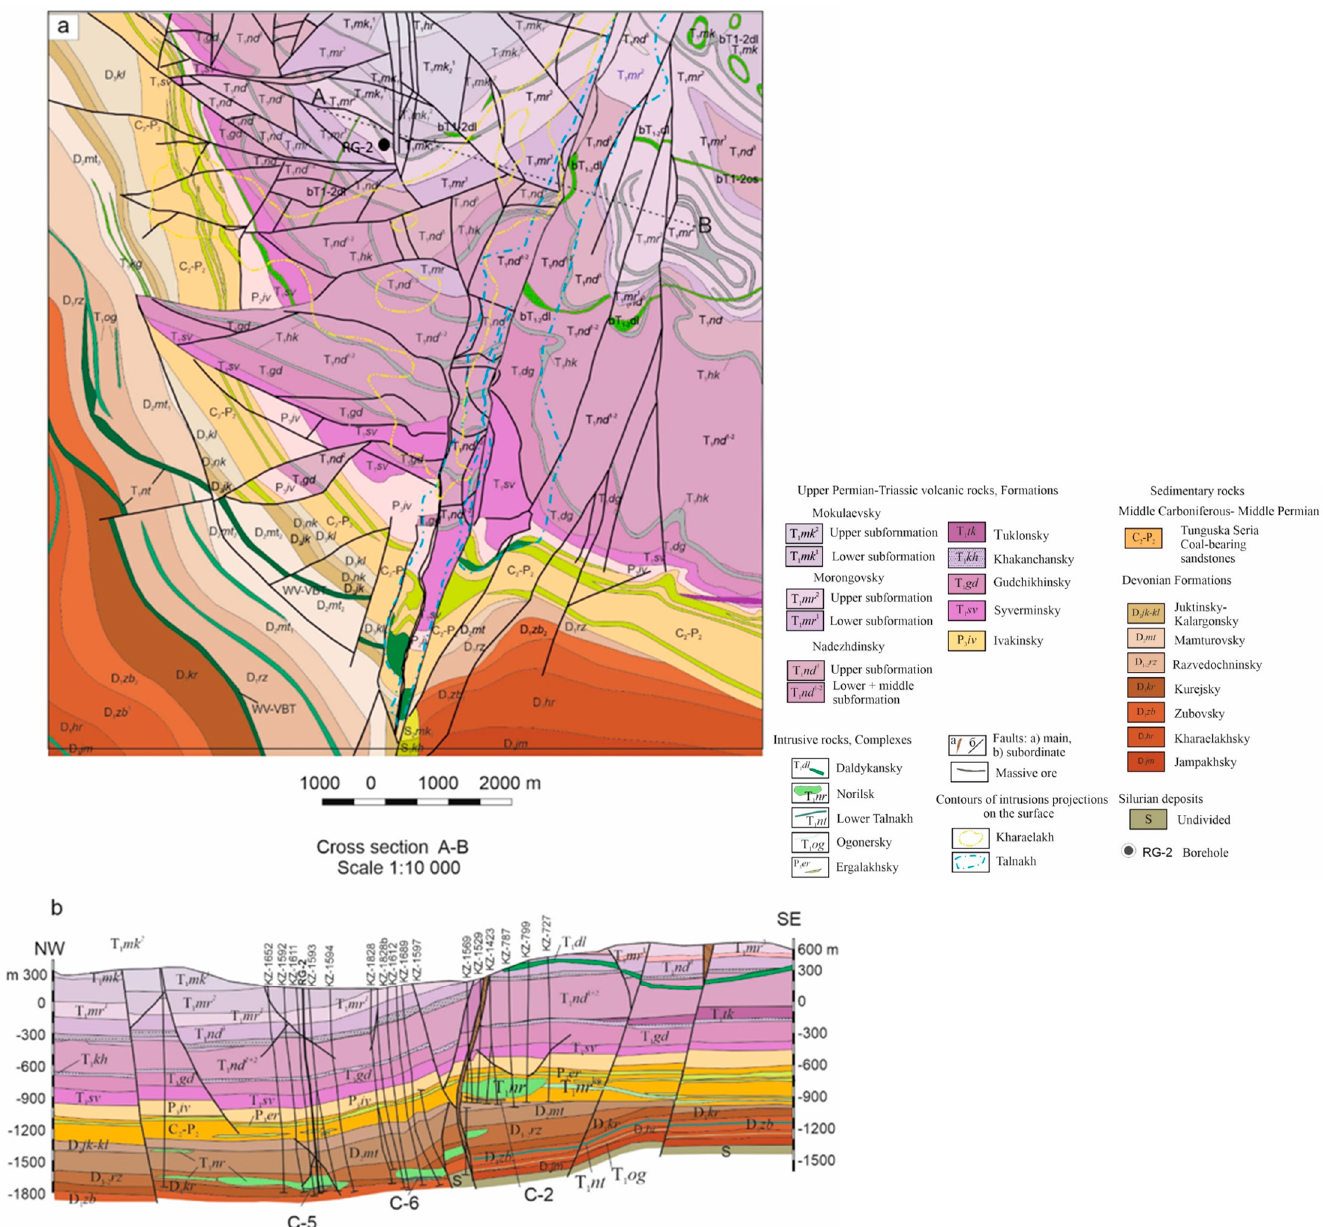
Figure 2. Geological map of the Talnakh ore junction ( a ) and sublatitude cross-section ( b ) (after Norilskgeology Ltd. data with additional corrections from the authors).